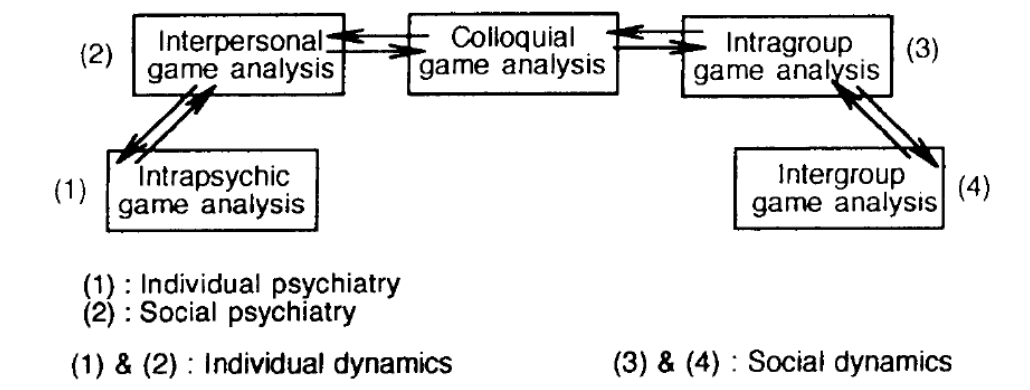
Figure 5: Two Planes of Game Analysis